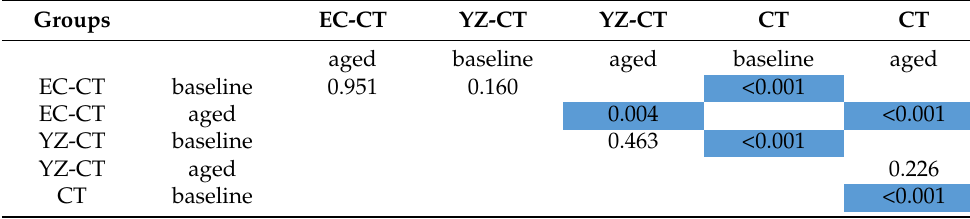
Table A2. Retention force: p -values (colored: significant difference p <